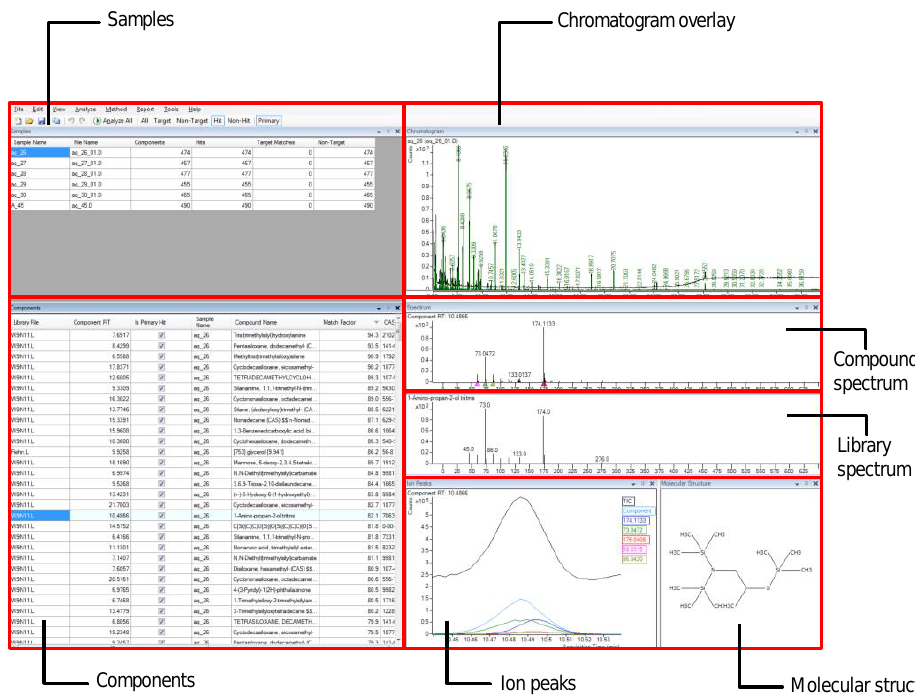
Figure 7. Fiehn/Wiley/NIST library matched analysis using Agilent MassHunter Unknown Analysis software.